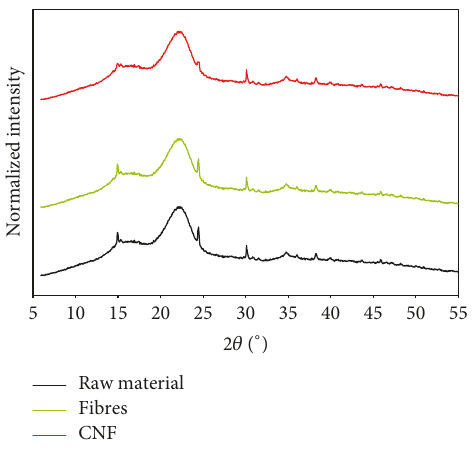
Figure 2: XRD pattern of Prunus amygdalus before pulping and their fibre and cellulose nanofibrils.